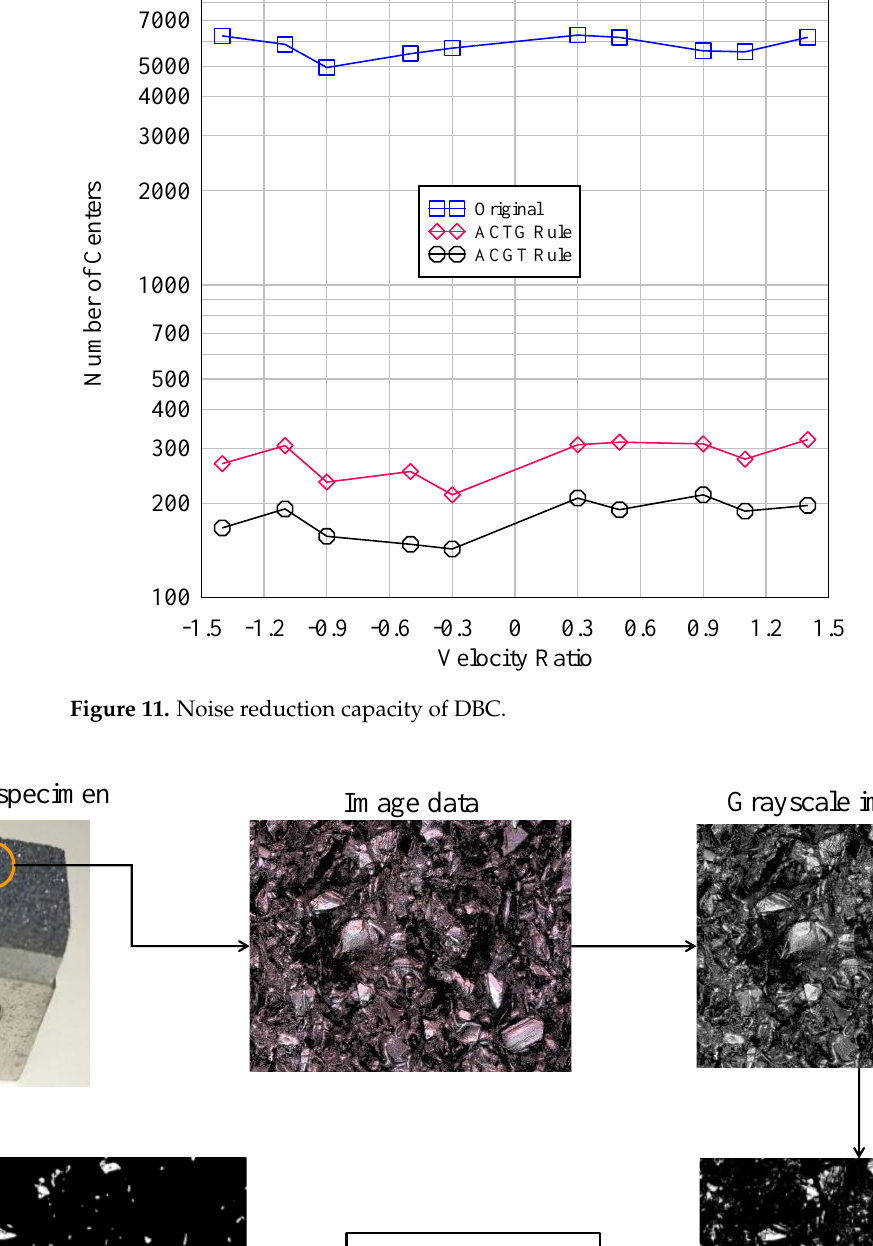
Figure 10. Binary images showing the efficacy of DBC.